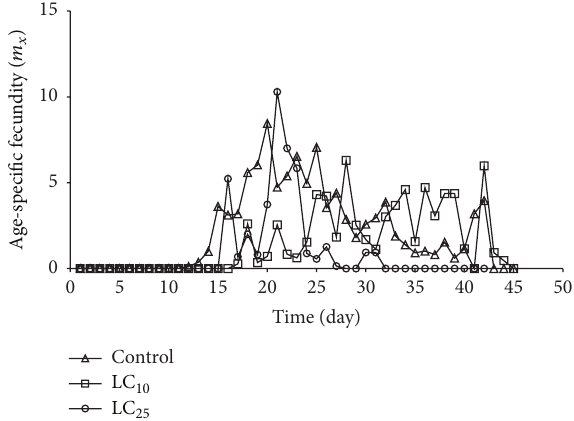
Figure 4: Age-specific fecundity ( 𝑚 𝑥 ) of P. xylostella treated with